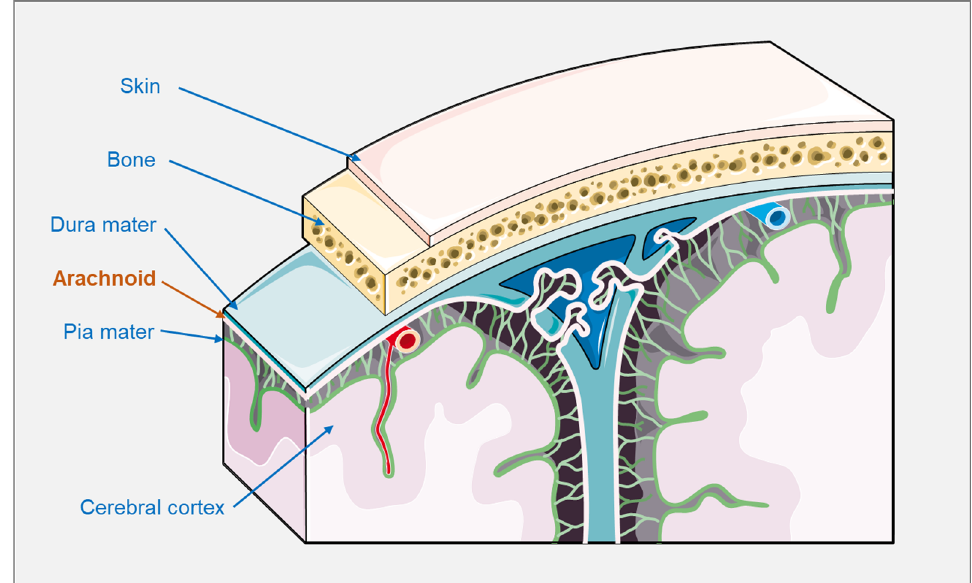
Fig. 1 Meningiomas arise from meningothelial and arachnoid cap cells of the leptomeninges and may progress to invade the dura mater